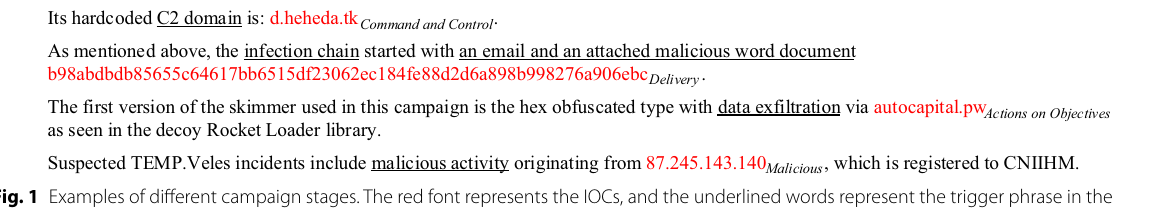
Fig. 1 Examples of different campaign stages. The red font represents the IOCs, and the underlined words represent the trigger phrase in the sentence, that is, keywords that can emphasize the category of the sentence. The phrase that follows in the lower right corner of the IOC indicates the campaign stage of the IOC and the campaign stage to which the sentence